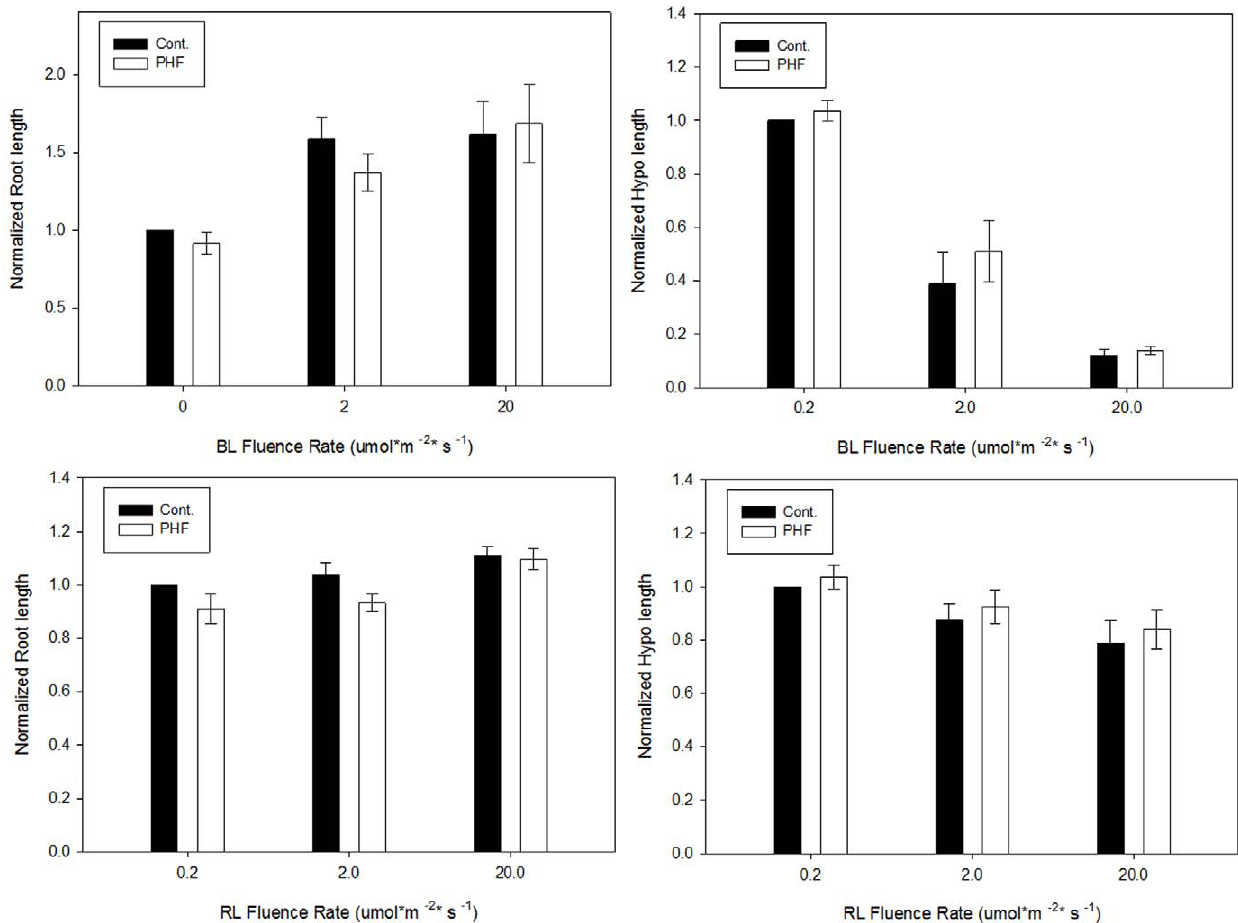
Figure 4. Normalized root or hypocotyl lengths of Arabidopsis seedlings under blue light (BL) or red light (RL) conditions. PHF concentration was 100 mg/L. No difference on root and hypocotyl elongation was observed under those two monochromatic light conditions (p . 0.05). Root and hypocotyl lengths were all normalized to control that grown under 0.2 m mol m 2 2 s 2 1 BL or RL within each experimental replicate. At least 25 seedlings per treatment were measured in each replicate. Error bars represent the standard deviation of the three independent